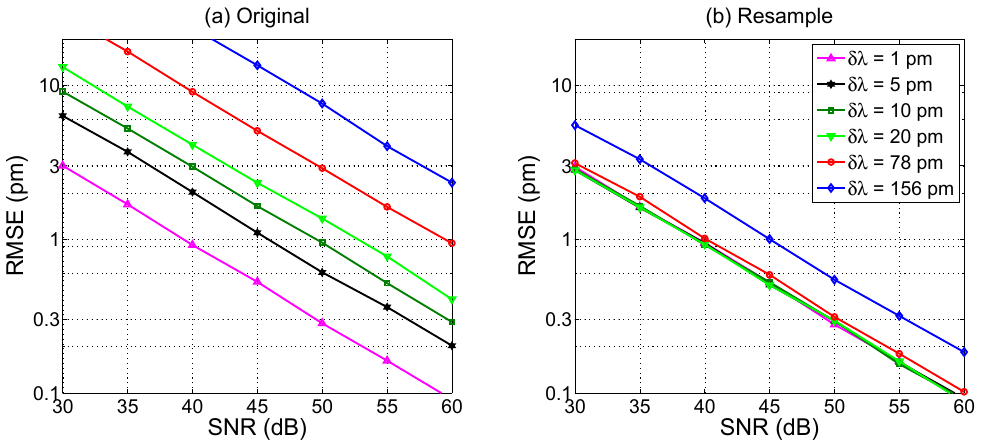
Figure 20. Performance analysis of 2nd order polynomial peak tracking technique: the RMSE on peak detection is reported as a function of SNR, for different values of sampling grid δλ (1 pm, 5 pm, 10 pm, 20 pm, 78 pm, 156 pm). ( a ) FBG spectra are processed without resampling. ( b ) FBG spectra have been resampled, on a new grid with δλ R = 1 pm.